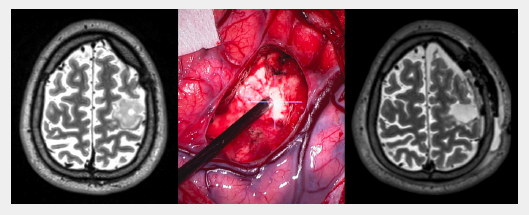
Example of a surgery for a lesion adjacent to eloquent tissue lesion. Left: Preoperative imaging reveals a glioma within the primary motor cortex. Middle: intraoperative continuous motor mapping guides surgery in proximity to the corticospinal tract. Right: postoperative imaging depicts gross total resection.